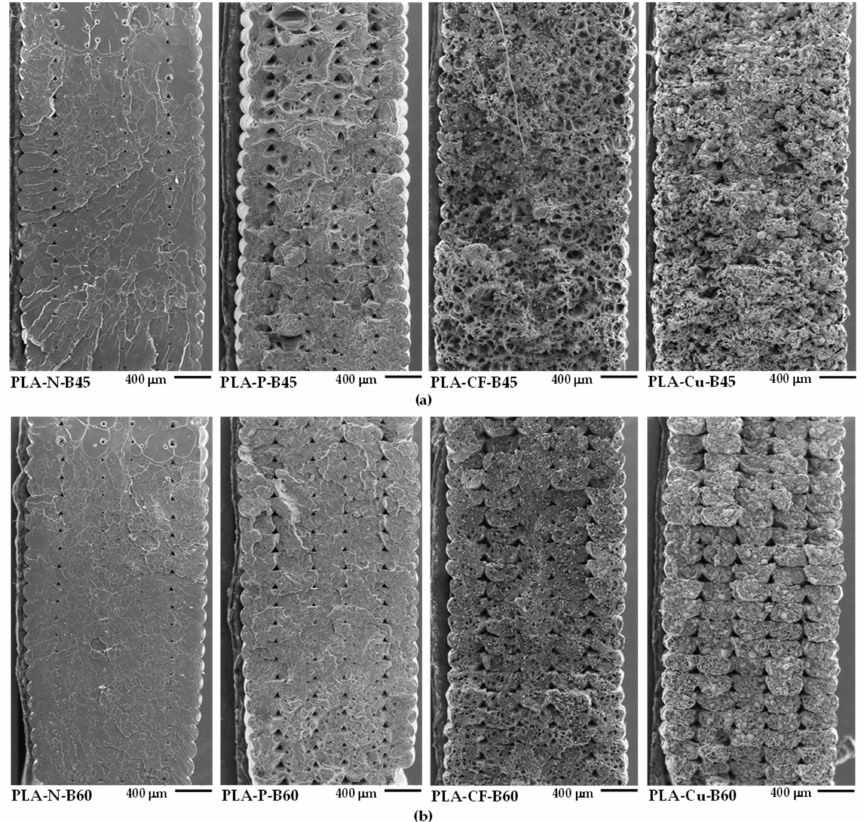
Figure 13. SEM images of tensile fractured surfaces of 3D printed samples: ( a ) at bed 45 ◦ C and ( b ) at bed 60 ◦